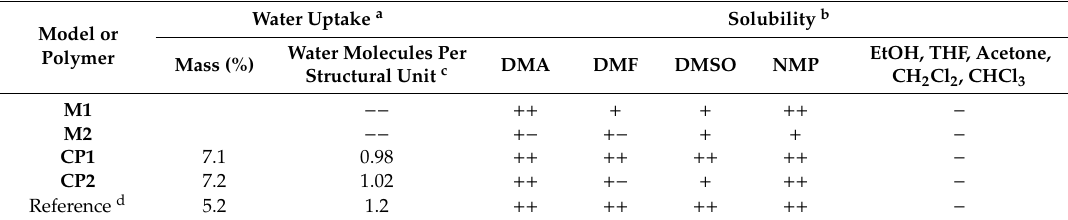
Table 2. Water uptake and solubility of aromatic polyamides and the models.